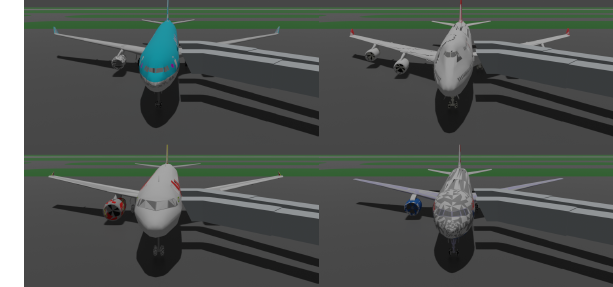
Figure 4. In ( a ) a procedurally generated landscape with vegetation is shown. A semi-static scene varied by aircraft models from free repositories is shown in ( b ).